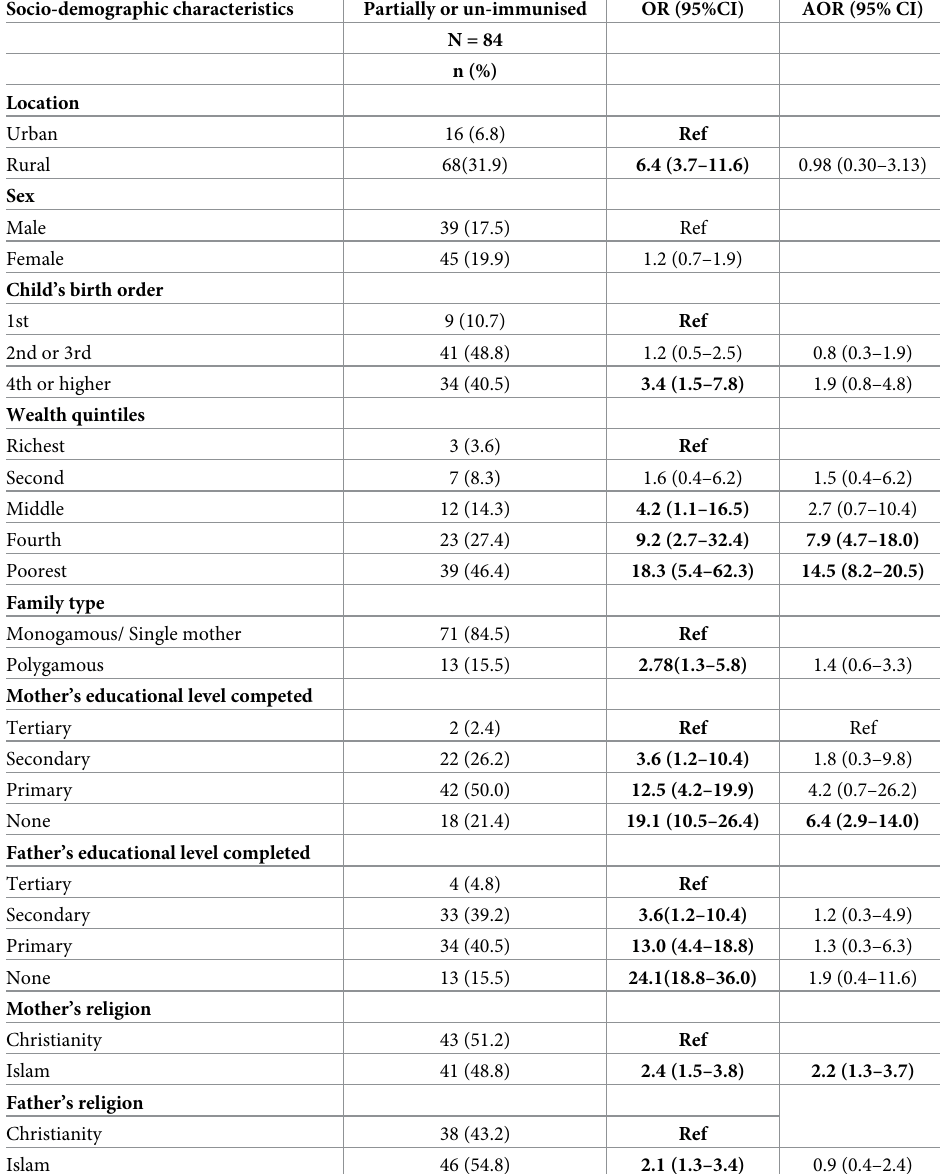
Table 4. Socio-demographic predictors of immunisation status, Akinyele LGA, Oyo State, Nigeria—2013. Socio-demographic